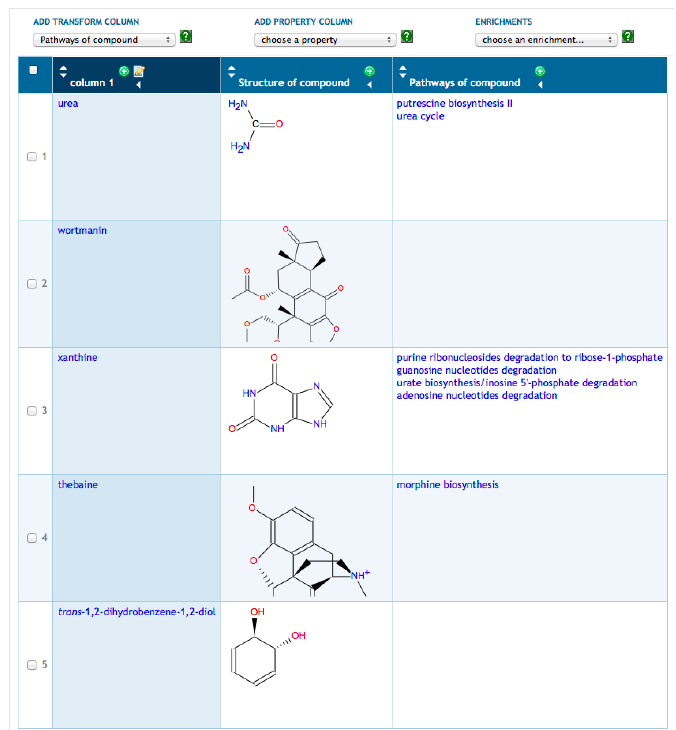
Figure 2. This metabolite SmartTable was derived from the SmartTable in Figure 1 by adding Column 3, which transforms the metabolites in Column 1 to the metabolic pathways containing those